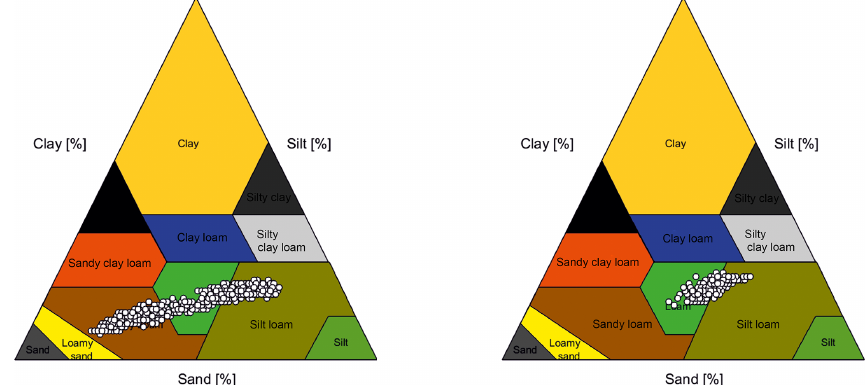
Figure 3. Soil texture triangles, illustrating the difference in soil textural variability of the Lower Saxony pixel (left) and the North Rhine- Westphalia pixel (right), according to USDA classification.